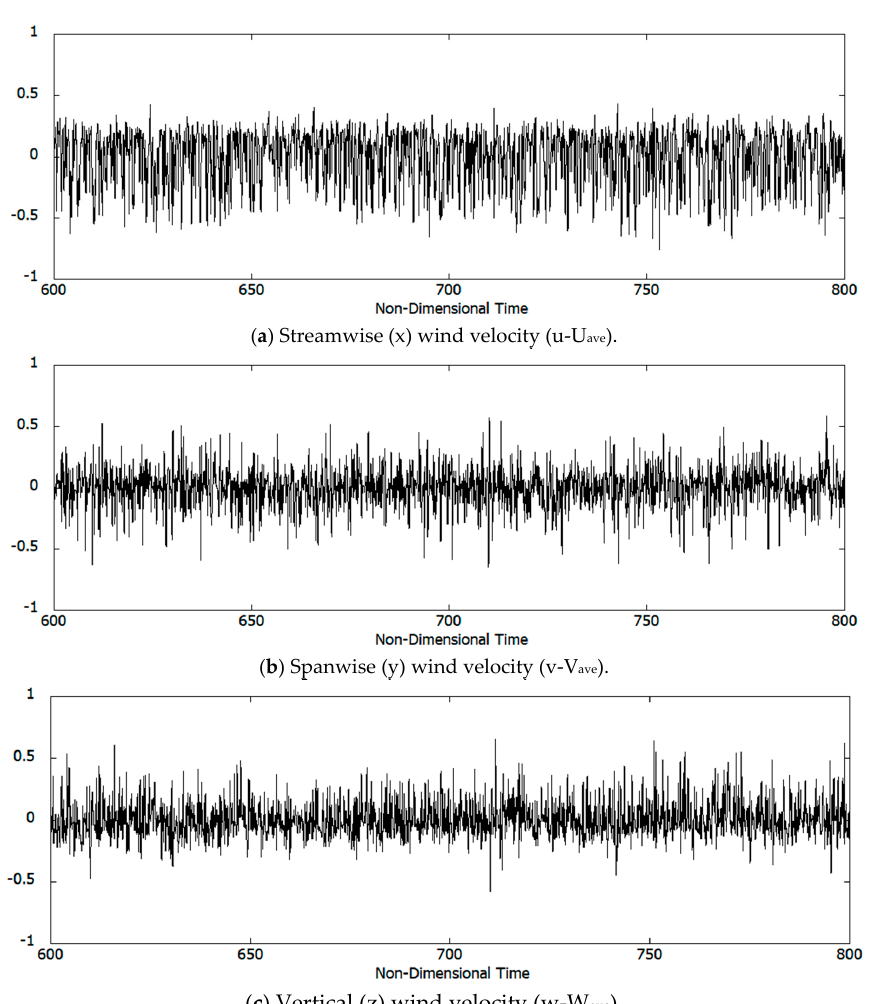
Figure 11. Temporal change of the fluctuating parts of the wind velocity components at the hub height (60 m above the ground surface) of T7.